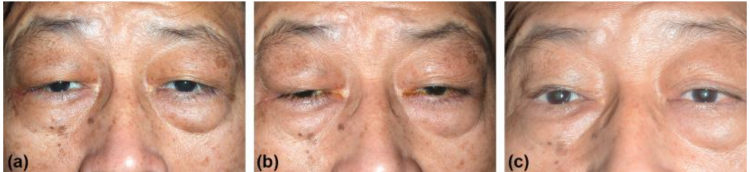
Figure 2. External photographs after orbitotomy (removal of the right lacrimal gland). ( a ) Three-week postoperative view showing reduced right upper eyelid swelling and proptosis. ( b ) Three-month postoperative view showing recurrent right upper eyelid swelling, and bilateral ptosis. ( c ) One-year postoperative view, six months after bilateral levator muscle advancement and right upper eyelid mass excision, showing marked improvement of right upper eyelid swelling and ptosis.